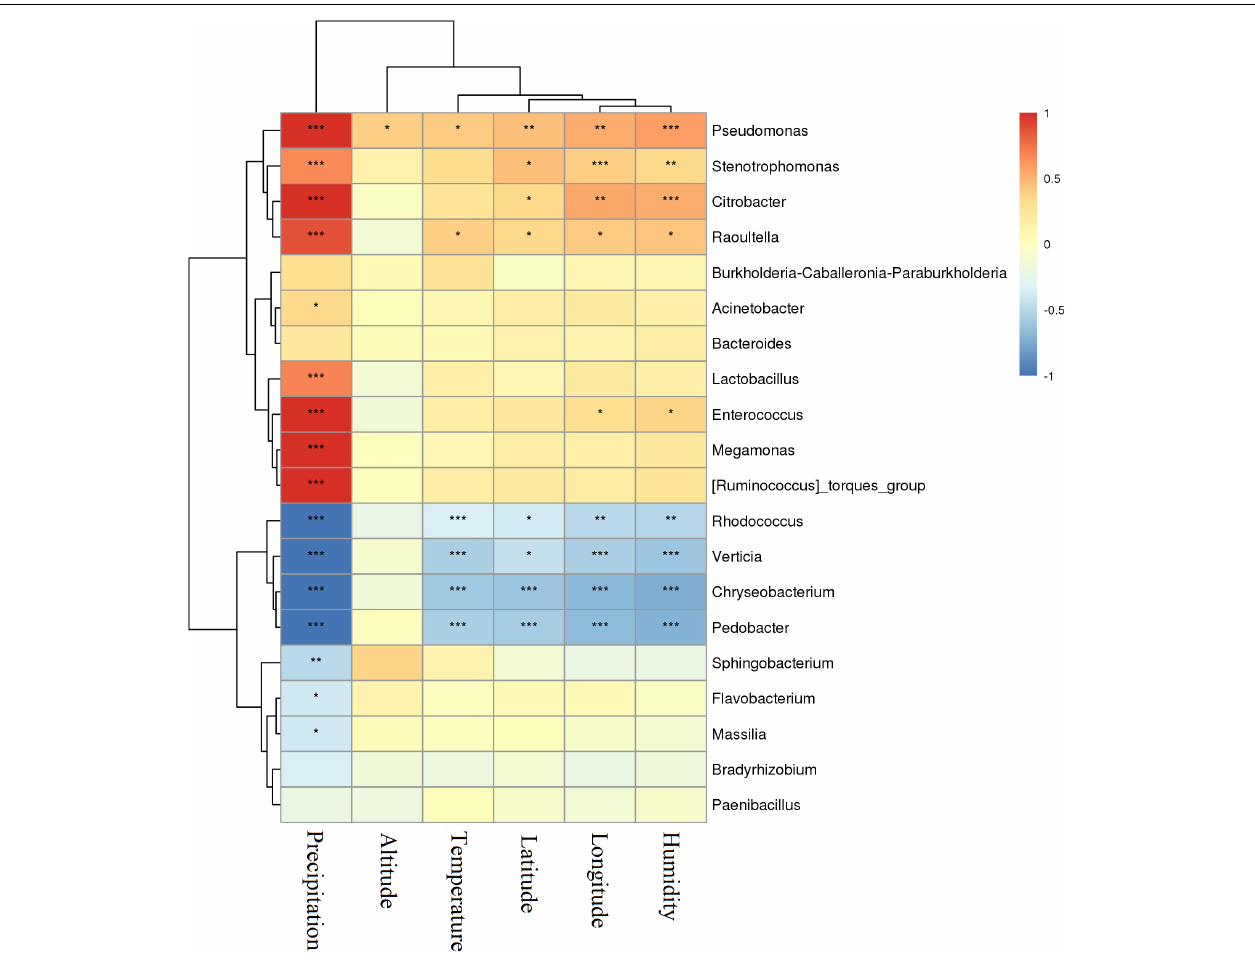
FIGURE 5 | Correlation of P. sinese silage bacterial communities and environmental factors (longitude, latitude, temperature, humidity, and precipitation) at genus level. The blue indicates a negative correlation, red indicates a positive correlation. “*” and “**” represent P < 0.05 and P < 0.01, respectively.